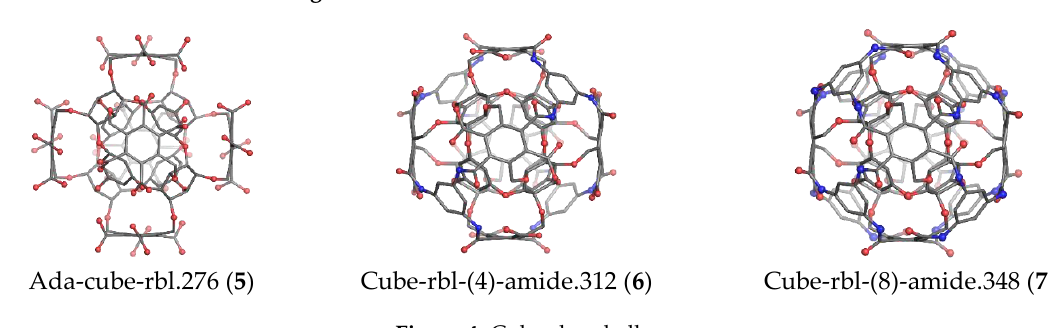
Figure 3. Adamantane motif in cube rhombellanes.